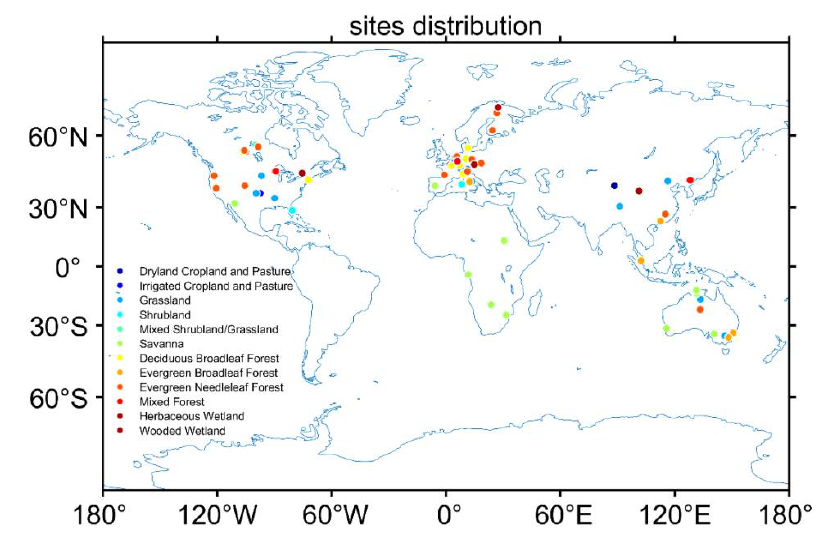
Figure 1. Distribution of FLUXNET sites used in this study. Colors represent the 12 vegetation coverage types.